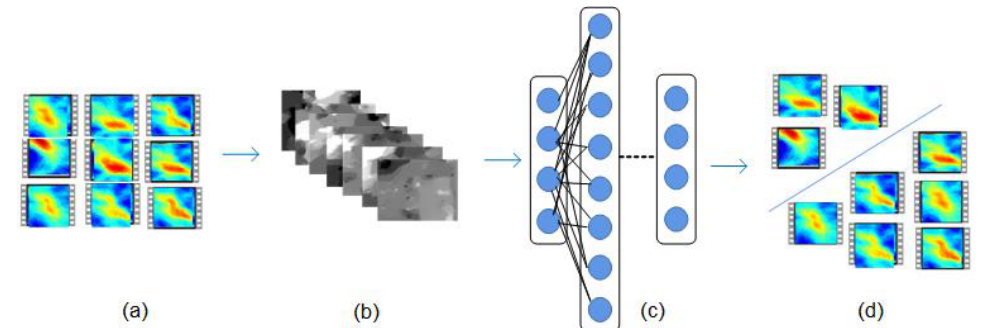
Figure 8. The oceanfront classification network is based on the GoogLeNet Inception network, including the following steps. First, the video sequence ( a ) is processed into warped optical flow images ( b ). Then, these images are sent to the GoogLeNet Inception network ( c ) for classification. The softmax layer ( d ) of the network produces the final scores, which are used to label the video sequence as an enhancement or attenuation trend. The ocean-front tracking algorithm. Firstly, the images are sent to the GoogLeNet Inception network to perform classification. The foreground images are changed to white, and the background image blocks remain unchanged. Finally, the images are used to reconstruct the video sequence.